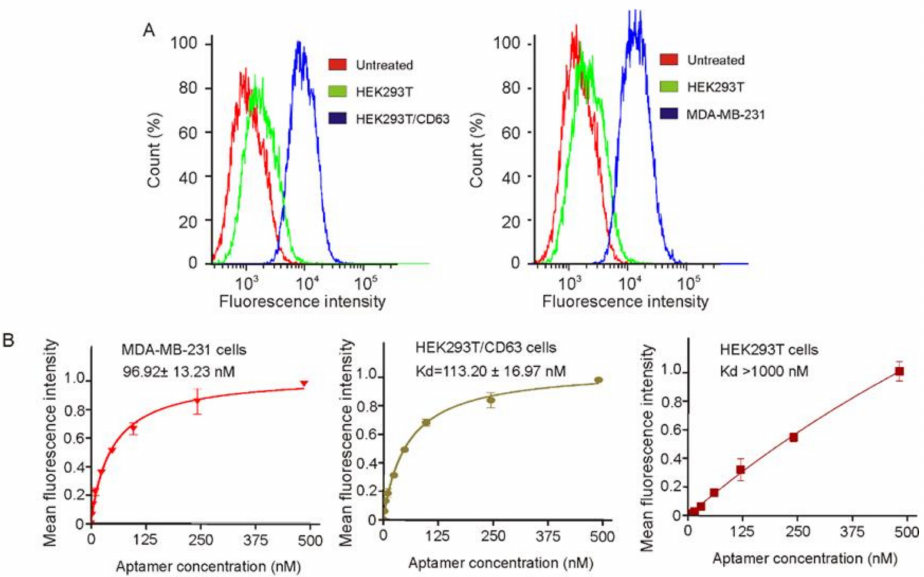
Figure3. AssessmentofbindingpropertiesofCD63-1aptamertoCD63-positivecells. ( A ).FAM-conjugated CD63-1 aptamer was incubated with CD63-positive or -negative cells at 37 ◦ C for 30 min at a concentration of 200 nM, followed by assessing the binding capacity of CD63-1 aptamer to CD63-positive cells with the CD63-negative HEK-293T cells as control; ( B ). Calculating the equilibrium dissociation constants of CD63-1 aptamer to CD63 positive cells via incubating cells with a series of concentrations of aptamer (0–500 nM). Before binding assay, the potential binding motifs of the protein were blocked via using excessive (50 µ g / 500 µ L / test) salmon sperm DNAs. Kd was calculated via GraphPad Prism program 3.03.